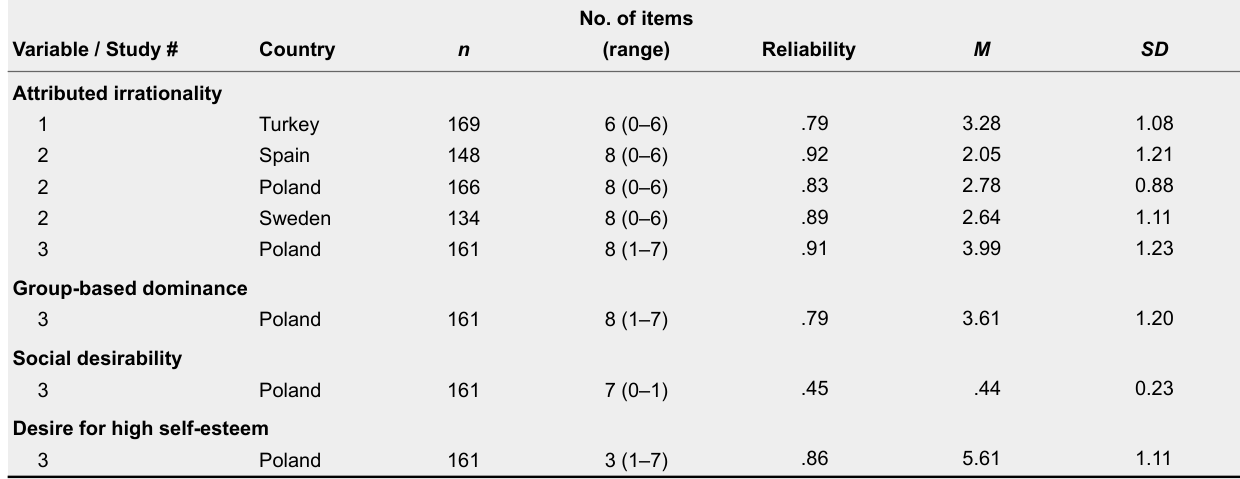
Descriptive Statistics for Measures Used in Studies